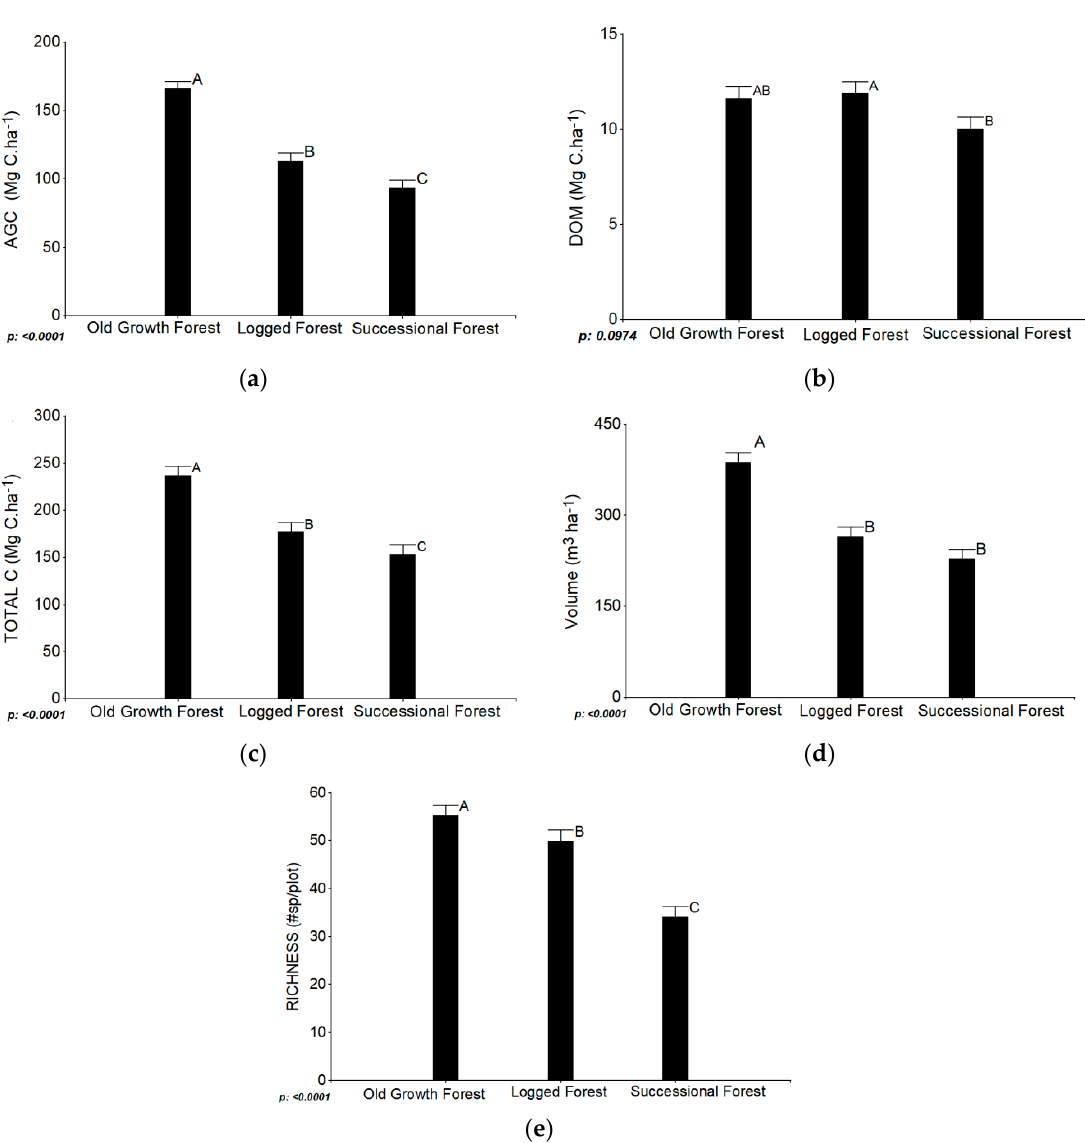
Figure 3. Analysis of variance for carbon stocks, timber volume and species richness between forest types. ( a ) AGC: Above-ground carbon stocks. ( b ) DOM: Dead organic matter. ( c ) Total C: Total carbon stocks. ( d ) Total tree volume. ( e ) Species richness. Different letters (A, B and C) indicate a significant difference from each other ( p ≤ 0.05 or p ≤ 0.10).